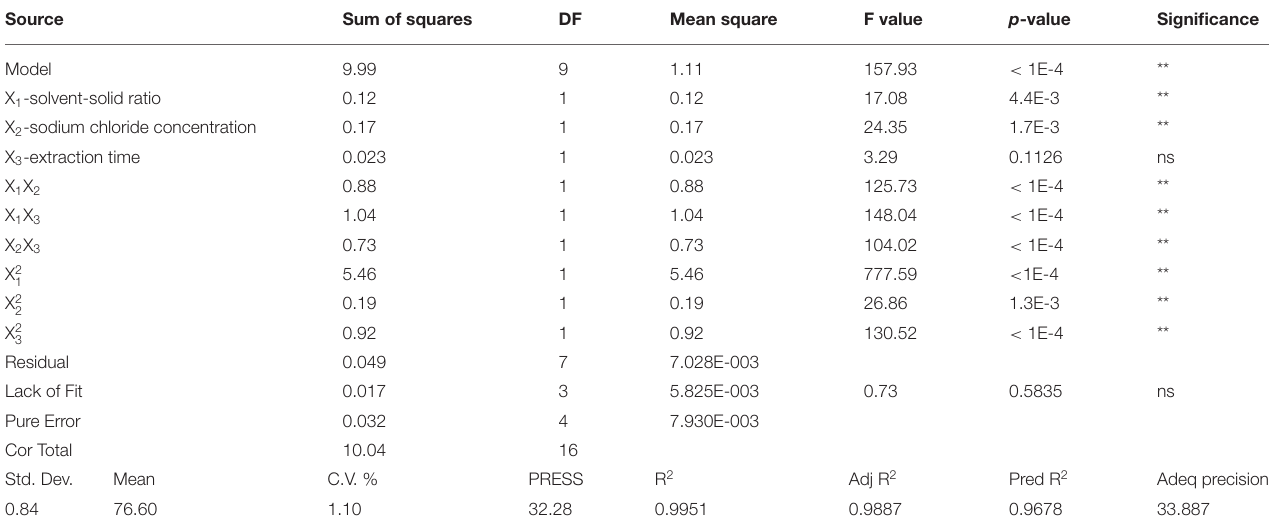
TABLE 2 | The ANOVA of the fitting model of TCEO by traditional hydrodistillation extraction. Source Sum of squares DF Mean square F value p -value Significance